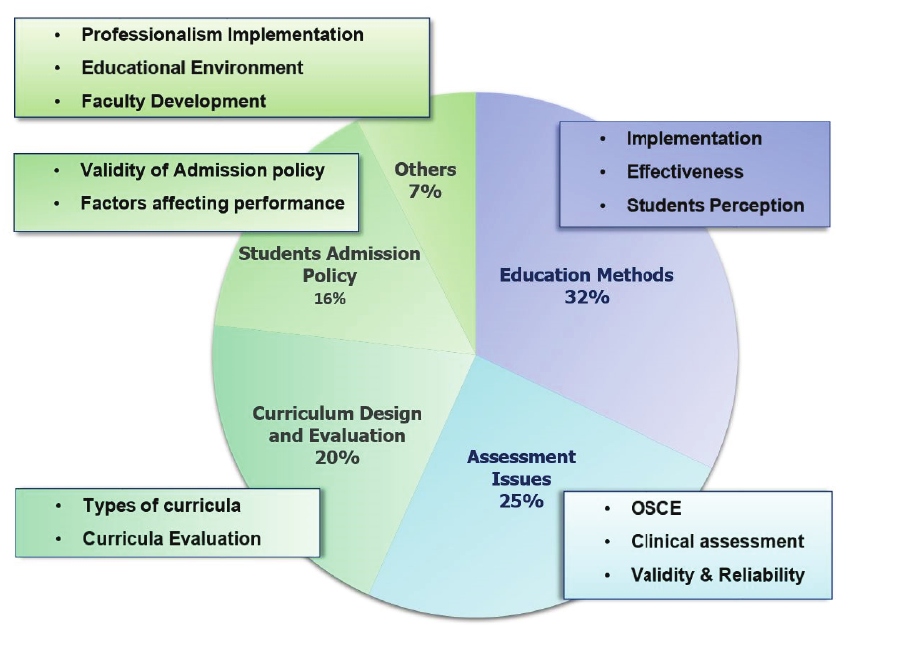
Figure 2 : Themes researched by ME Master’s graduates, their frequencies and included